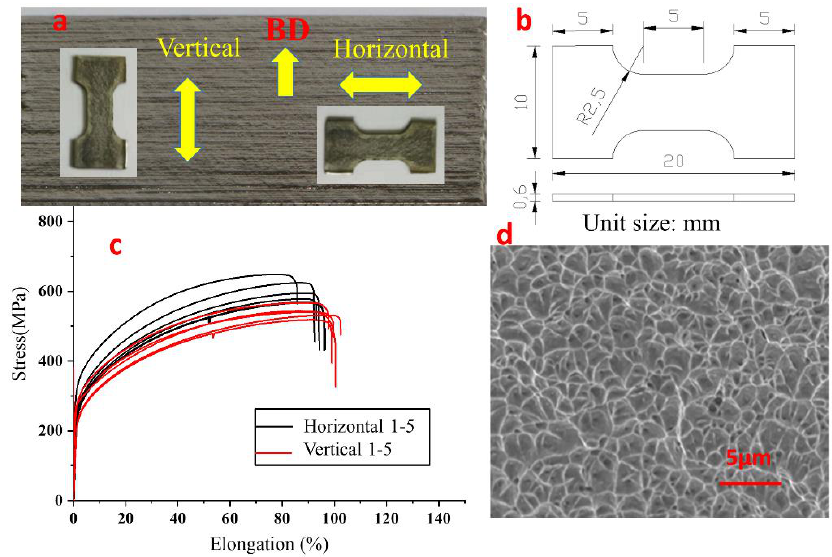
Figure 9. Tensile test and strength measurement of LJWF-DMD 316 L specimens. ( a ) Samples in vertical and horizontal directions. ( b ) Geometrical dimensions of the tensile specimen. ( c ) Stress/strain curves. ( d ) Scanning electron micrograph of fractures.